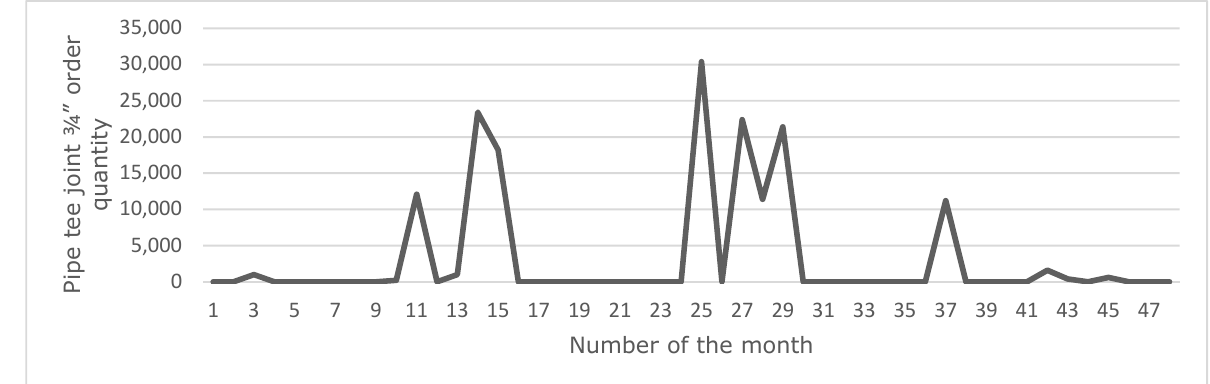
Figure 3. The historical demand of the Pipe Tee joint fitting ¾” for 48 months.